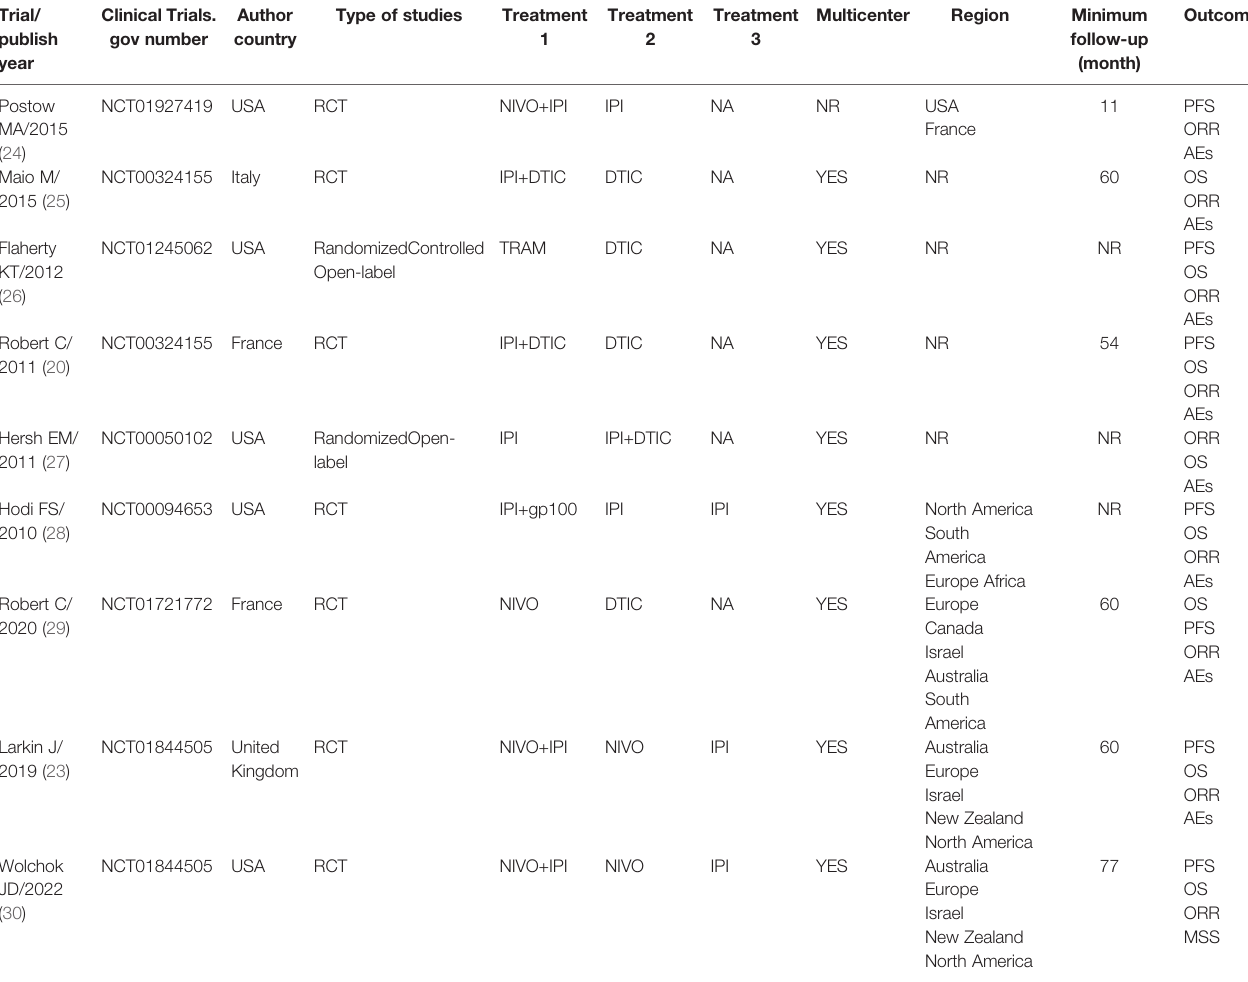
TABLE 1 | Characteristics of randomized controlled trials included in the